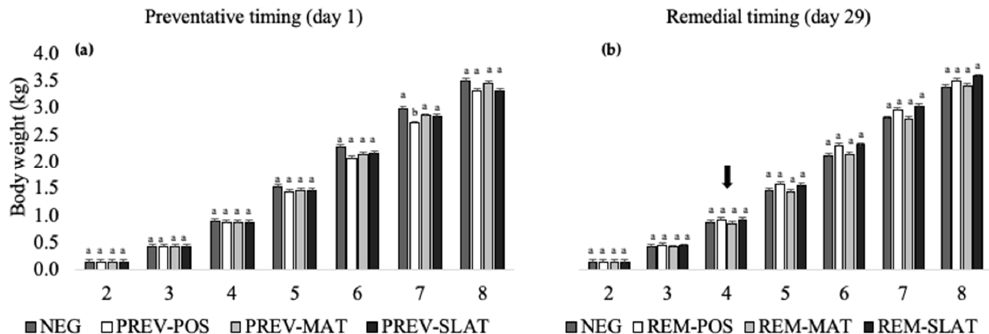
Figure 7. Mean body weights (kg) (raw means ± SEM) of birds that received ( a ) preventative provision of the flooring treatments (PREV) ( b ) or birds that received remedial provision of the flooring treatments (REM): negative control (NEG (presented twice)), clean litter (POS), iodine mat (MAT), or iodine mat with slatted floor (SLAT) during weeks 2 through 8 of age. The arrow in (b) indicates the timing application of the remedial treatments. Means in a flooring × timing treatment combination with different superscripts ( a–b ) differ significantly at p < 0.05.